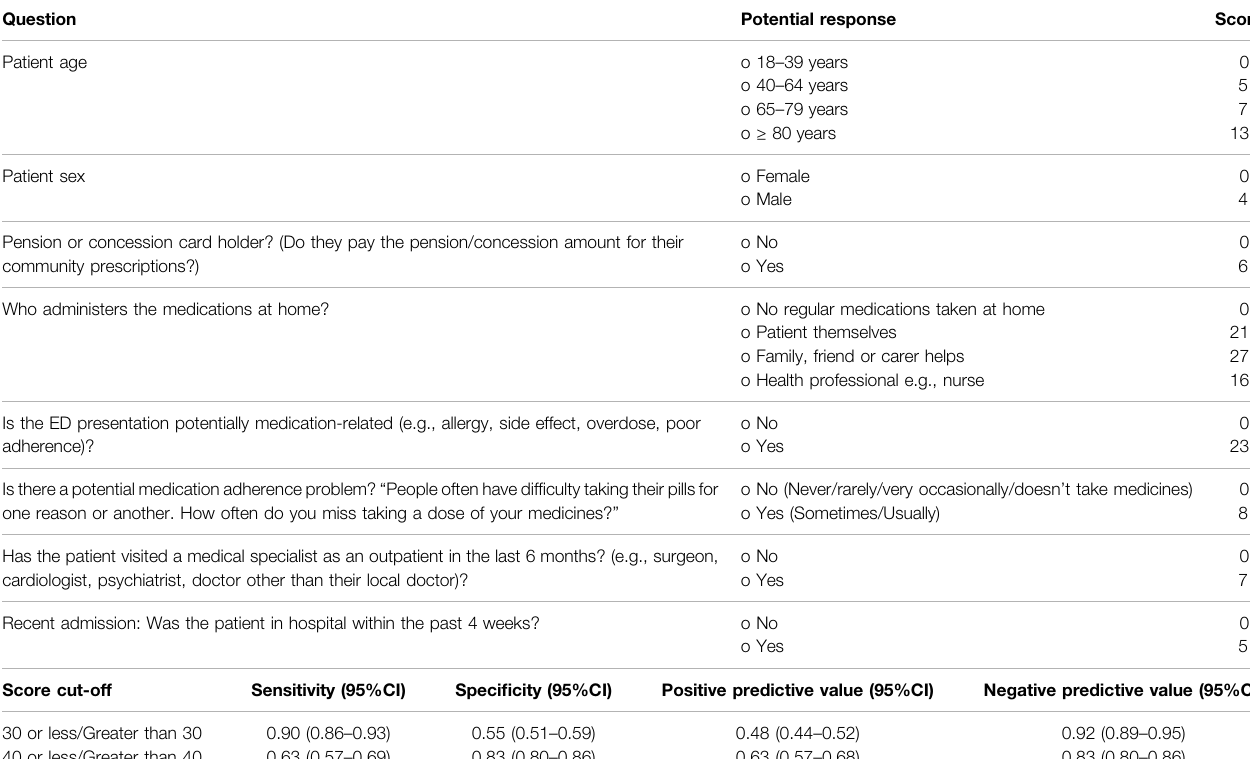
TABLE 4 | ED Presentation medication-related problem screening